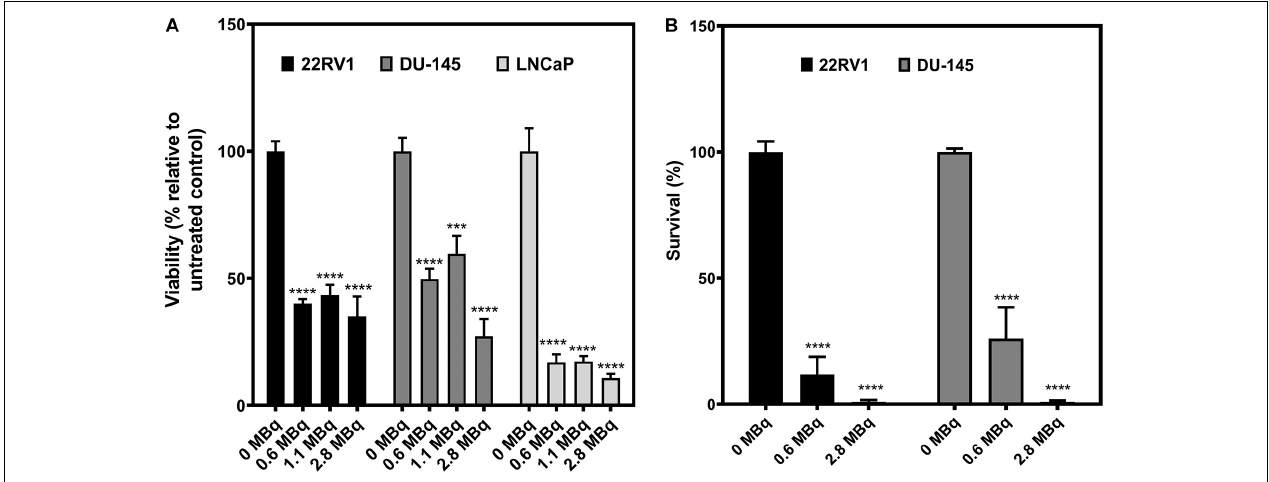
FIGURE 5 | Inhibitory effect of 64 CuCl 2 exposure on the viability of PCa spheroids and on the proliferation of spheroid-derived cells. (A) Viability of spheroids from human PCa cell lines assessed 8 days after exposure of 64 CuCl 2 using the APH assay, and normalized to each cell line’s respective untreated control. (B) Survival fractions of PCa spheroids-derived cells after 3 h of exposure to 64 CuCl 2 , represented as a percentage of the untreated control assessed using the clonogenic assay. Data are presented as the average ± S.E.M. of 3 or 2 independent assays for A and B, respectively. *** p < 0.001, **** p <